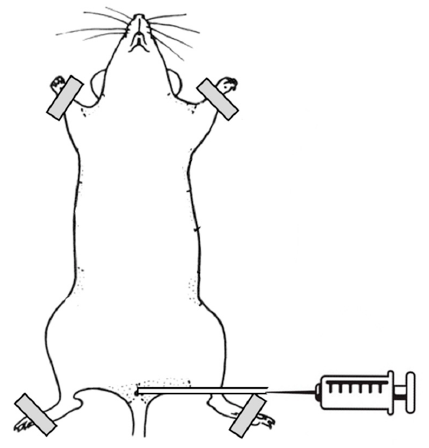
Figure 2. Schematic design of in vivo experiments.